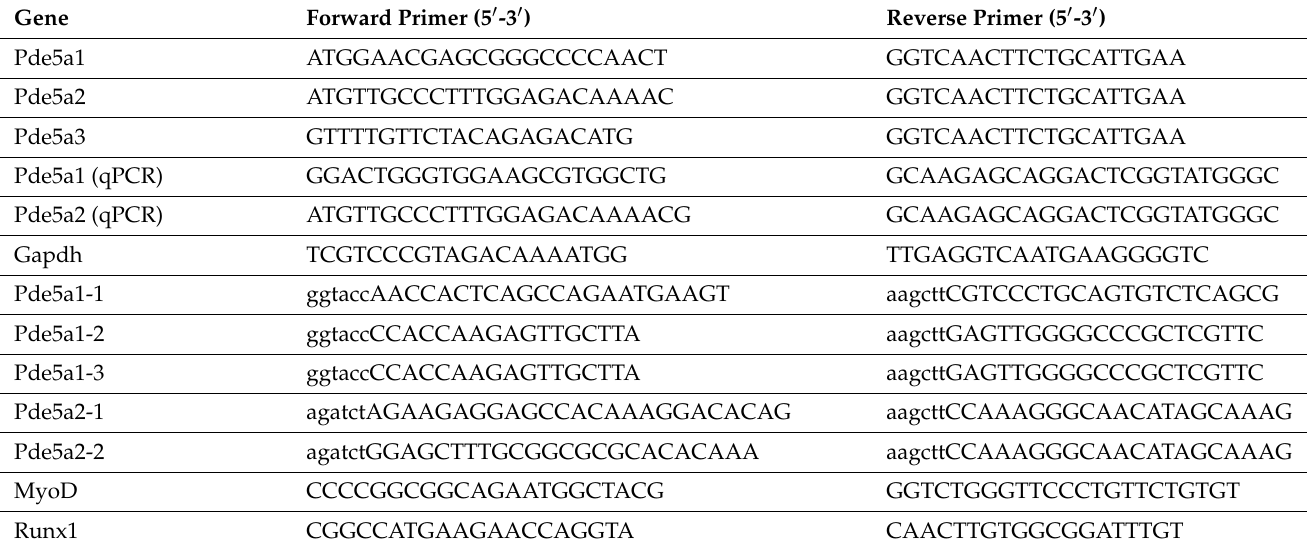
Table 1. Primers used in RNA analysis and promoters